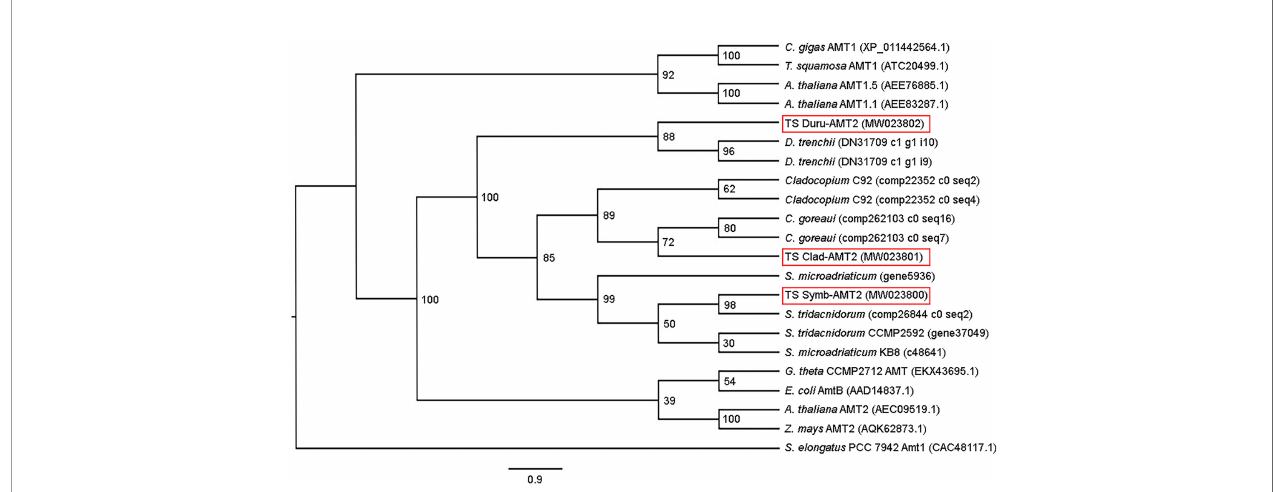
FIGURE 2 | Phenogramic analysis of ammonium transporter 2 (AMT2) from Symbiodinium (Symb-AMT2), Cladocopium (Clad-AMT2), and Durusdinium (Duru-AMT2) obtained from the outer mantle of Tridacna squamosa . Numbers at each branch point represent bootstrap values from 2000 replicates. Amt1 from Synechococcus elongatus is used as the outgroup for comparison. Amino acid sequences of ammonia transporters from the bacterium ( Escherichia coli ), algae ( Cladocopium C92, C. goreaui , Durusdinium trenchii , Guillardia theta , Symbiodinium tridacnidorum , and S. microadriaticum ), higher plants ( Arabidopsis thaliana and Zea mays ), bivalves ( Crassostrea gigas and T. squamosa ), were obtained from Genbank or various dino fl agellate databases with their accession or contig numbers given in